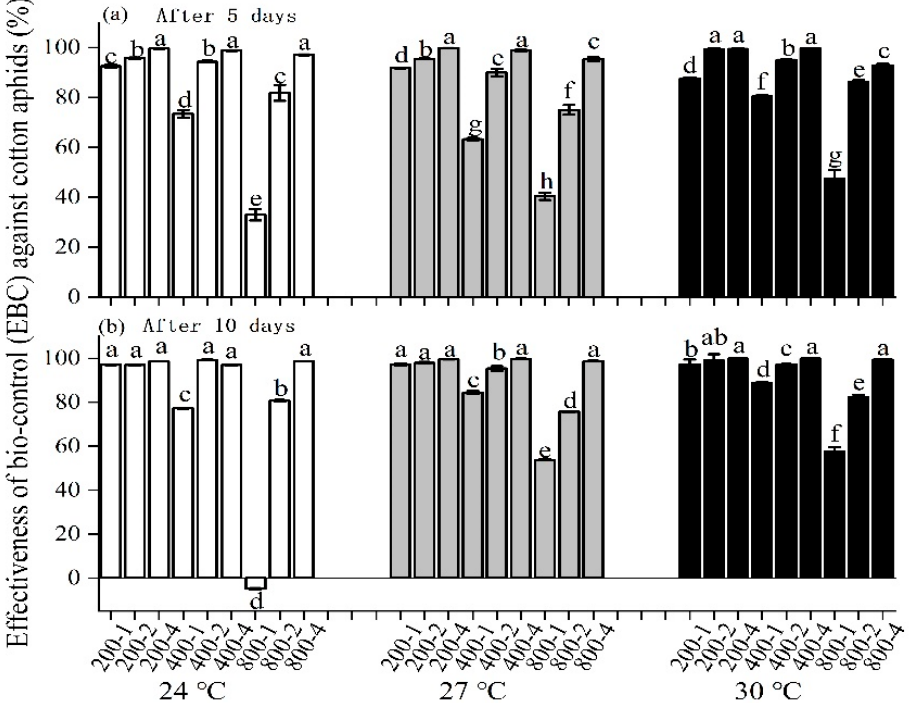
Figure 4. Effectiveness of biocontrol (EBC) against cotton aphids at ( a ) 5 days and ( b ) 10 days after releasing predators in laboratory experiments under various constant temperature regimes (the label in x axis presents the initial number of aphids and predators in cages).Different letters showed the mean of EBC that was different among each treatment in ( a , b ), while one-way ANOVA was used for comparison within one regime of temperature, respectively.